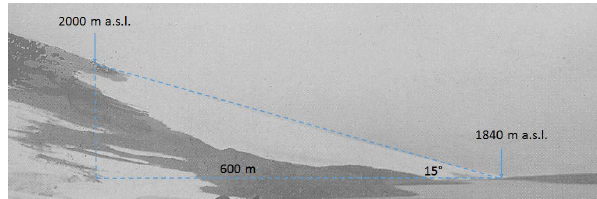
Figure 17. Picture taken from Vesljuvbrea towards the NNW show- ing Juvfonne from around 1900. The surface slope of Juvfonne is approximately 15 ◦ . Height and length estimate from map based on position in the picture. The upper and northern part of Juvfonne cannot be seen in the